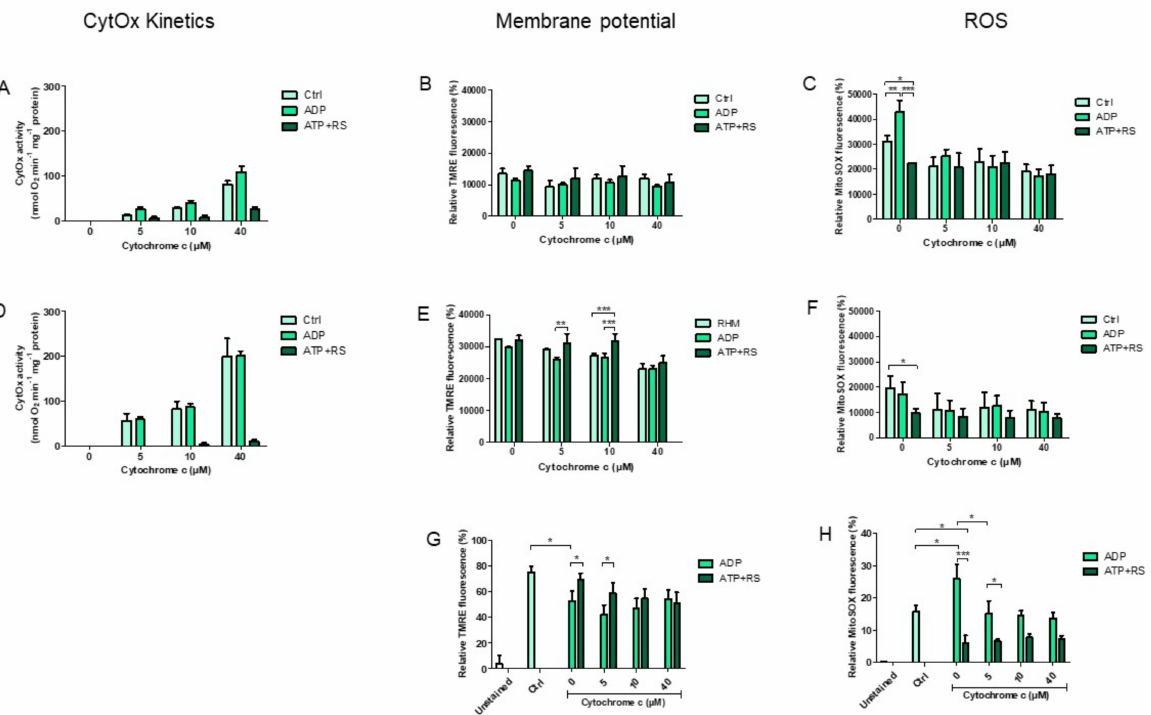
Figure 3. Comparison of CytOx kinetics to mitochondrial membrane potential and ROS production measurements. The kinetics of CytOx activity was measured in 1.128 mg/mL ± 0.07 mitochondria ( A ) and was correlated with the membrane potential ( B ) and ROS productions ( C ) performed by spectrofluorometry ( n = 4 individual experiments). Similarly, measurements were also performed using 0.054 mg/mL ± 0.004 mitochondria, i.e., CytOx kinetics ( D ), ∆Ψ m ( E ) and ROS ( F ). Additionally, membrane potential ( G ) and ROS production ( H ) were also measured by flow cytometry ( n = 3 individual experiments) in 0.054 mg/mL ± 0.004 mitochondria. The concentrations of added substrates were: 5 mM ADP or 5 mM ATP + RS (10 mM PEP + 160 U/mL PK). Each sample was measured at 0, 5, 10